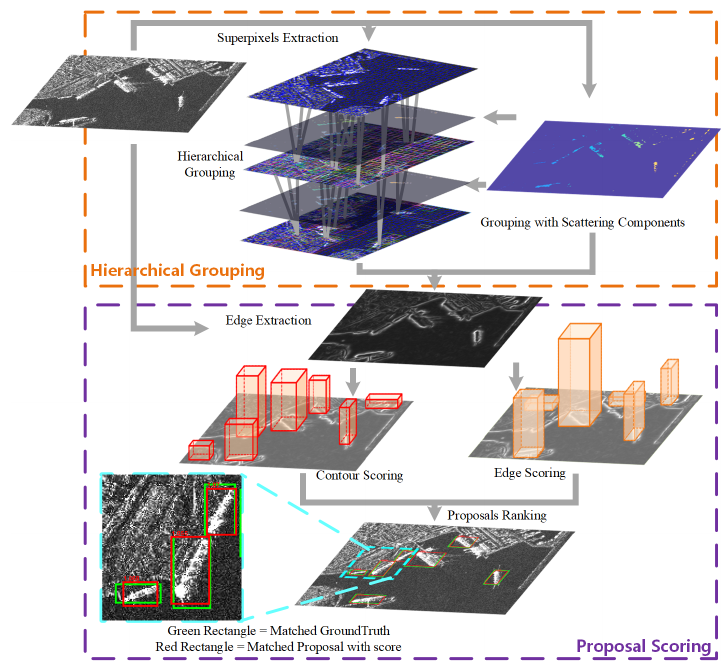
Figure 2. The framework of our suggested ship proposal generator. Algorithm 1: Hierarchical Grouping using Superpixels and Strong Scattering